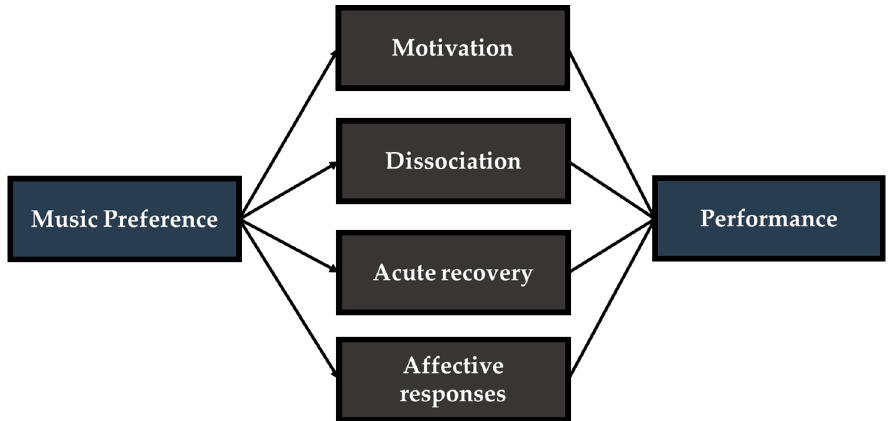
Figure 2. The majority of evidence has suggested that music preference influences exercise performance via the following mechanisms: motivation, dissociation (lower RPE), acute recovery, and affective responses. Interactions between both psychological and physiological mechanisms are responsible for ergogenic effects. Furthermore, preferred and non-preferred music may mediate performance through a single factor listed above or through multiple mechanisms which complement one another. Table 1. Reviewed studies on how music preference influences the exercise response and performance. Conditions, when the music intervention was applied (timing of music), type/mode of exercise (exercise), and primary findings from each investigation are presented. ↑ indicates an increase, ↓ a decrease, ↔ no change in the outcome. RPE = rate of perceived